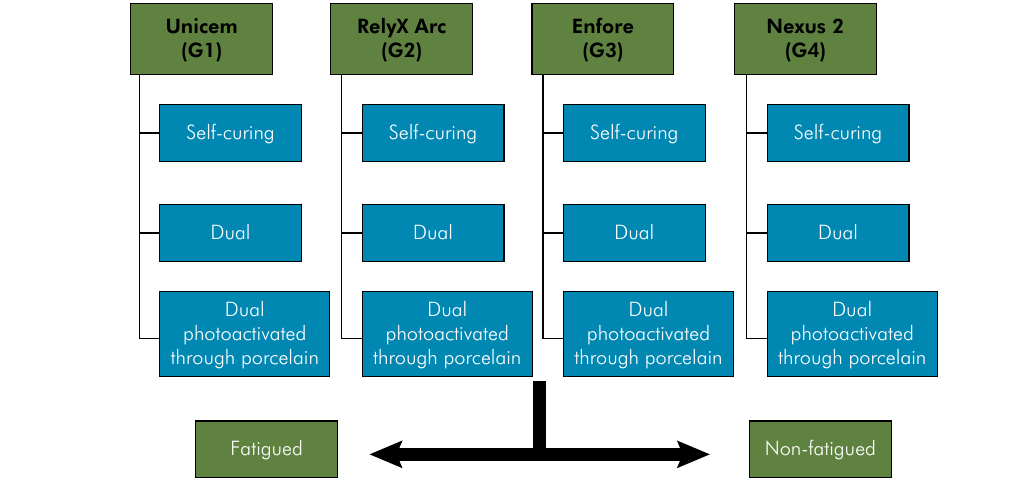
Figure 1. Experimental Groups where, G1 is Unicem, G2 is RelyX ARC, G3 is ENFORCE and G4 is Nexus 2; The second line is indicating activation mode Self-Curing, Dual Cure and Dual with photoactivation through porcelain (c).